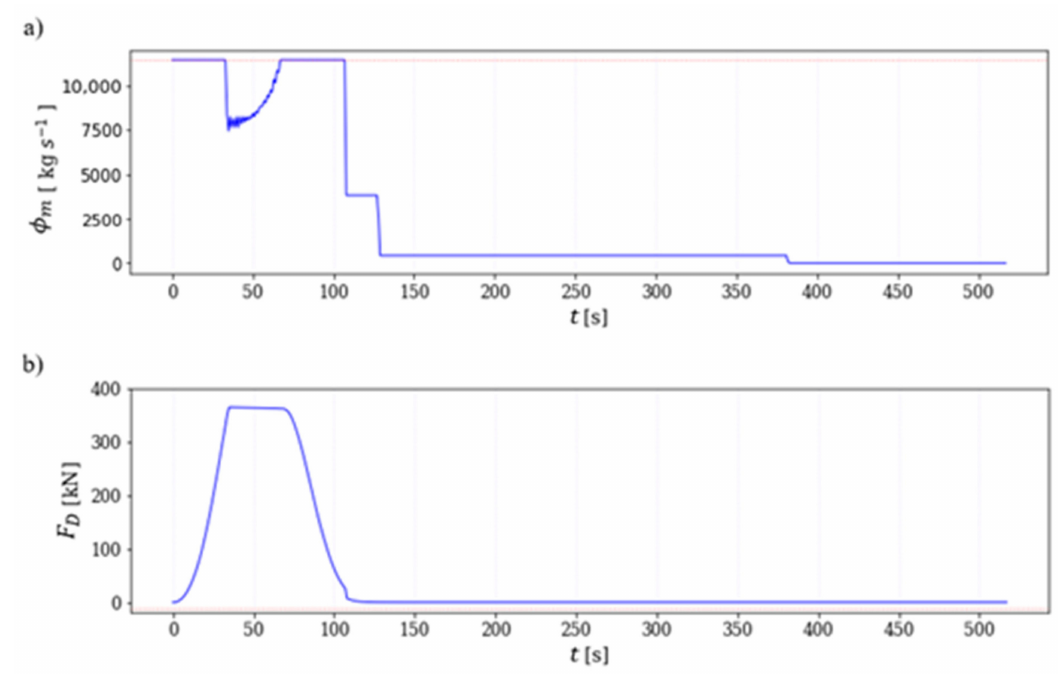
Figure 4. Time dependence of: ( a ) mass flow ( φ m ) and ( b ) drag ( F D ) for optimised flight.